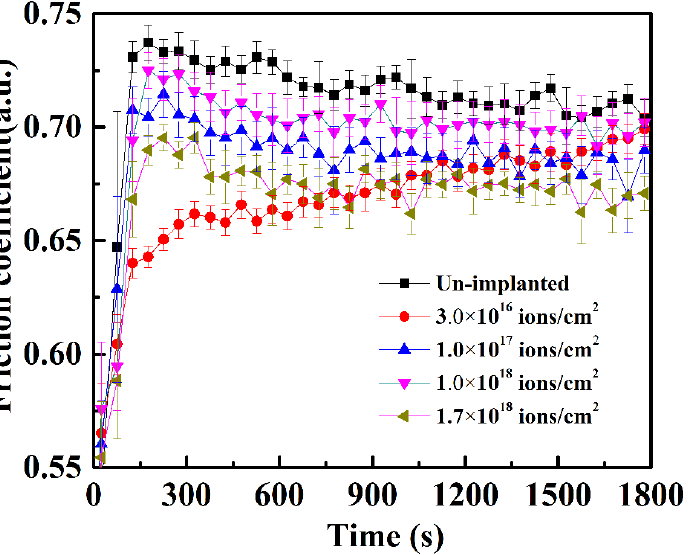
Figure 7. Friction coefficient of 316L stainless steel samples with different Ti ion implantation